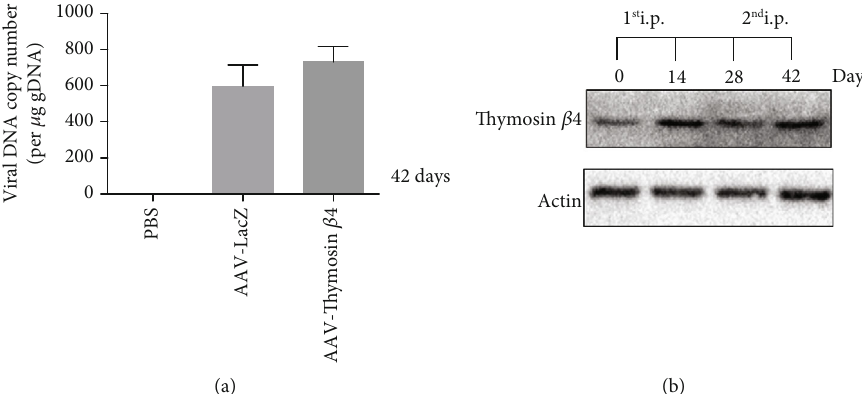
Figure 3: Expression of T β 4 in mouse heart tissues after intraperitoneal (i.p.) administration of an adeno-associated virus containing Thymosin 4. qRT-PCR revealed the expression of vector DNA in NC, AAV-LacZ, and AAV-T β 4 mice (a). Western blot revealed the expression of T β 4 in the mouse heart tissues